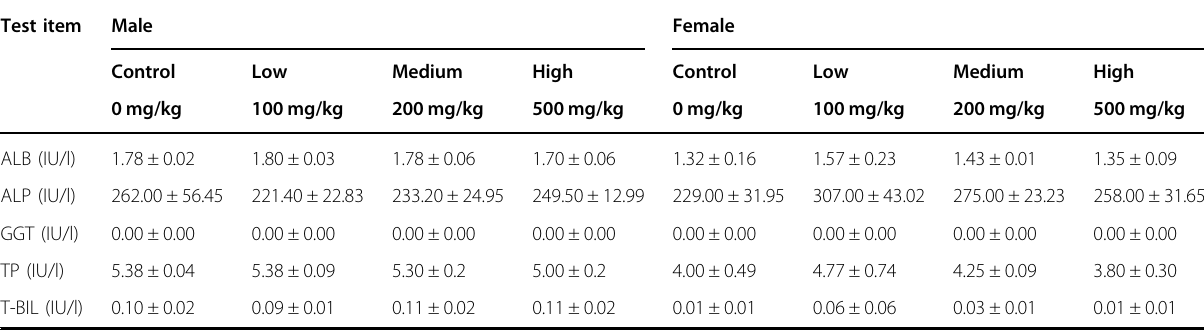
Table 1 Biochemical analysis of sera of male and female mice in the single dose toxicity test Test